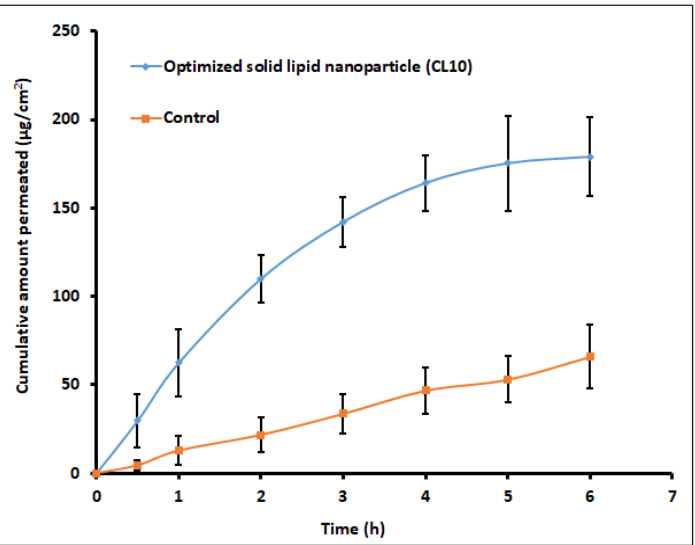
Figure 11. Cumulative amount of clarithromycin permeated through the goat cornea from solid lipid nanoparticles (CL10) and control (solution). Data represented are mean ± SD ( n = 6).